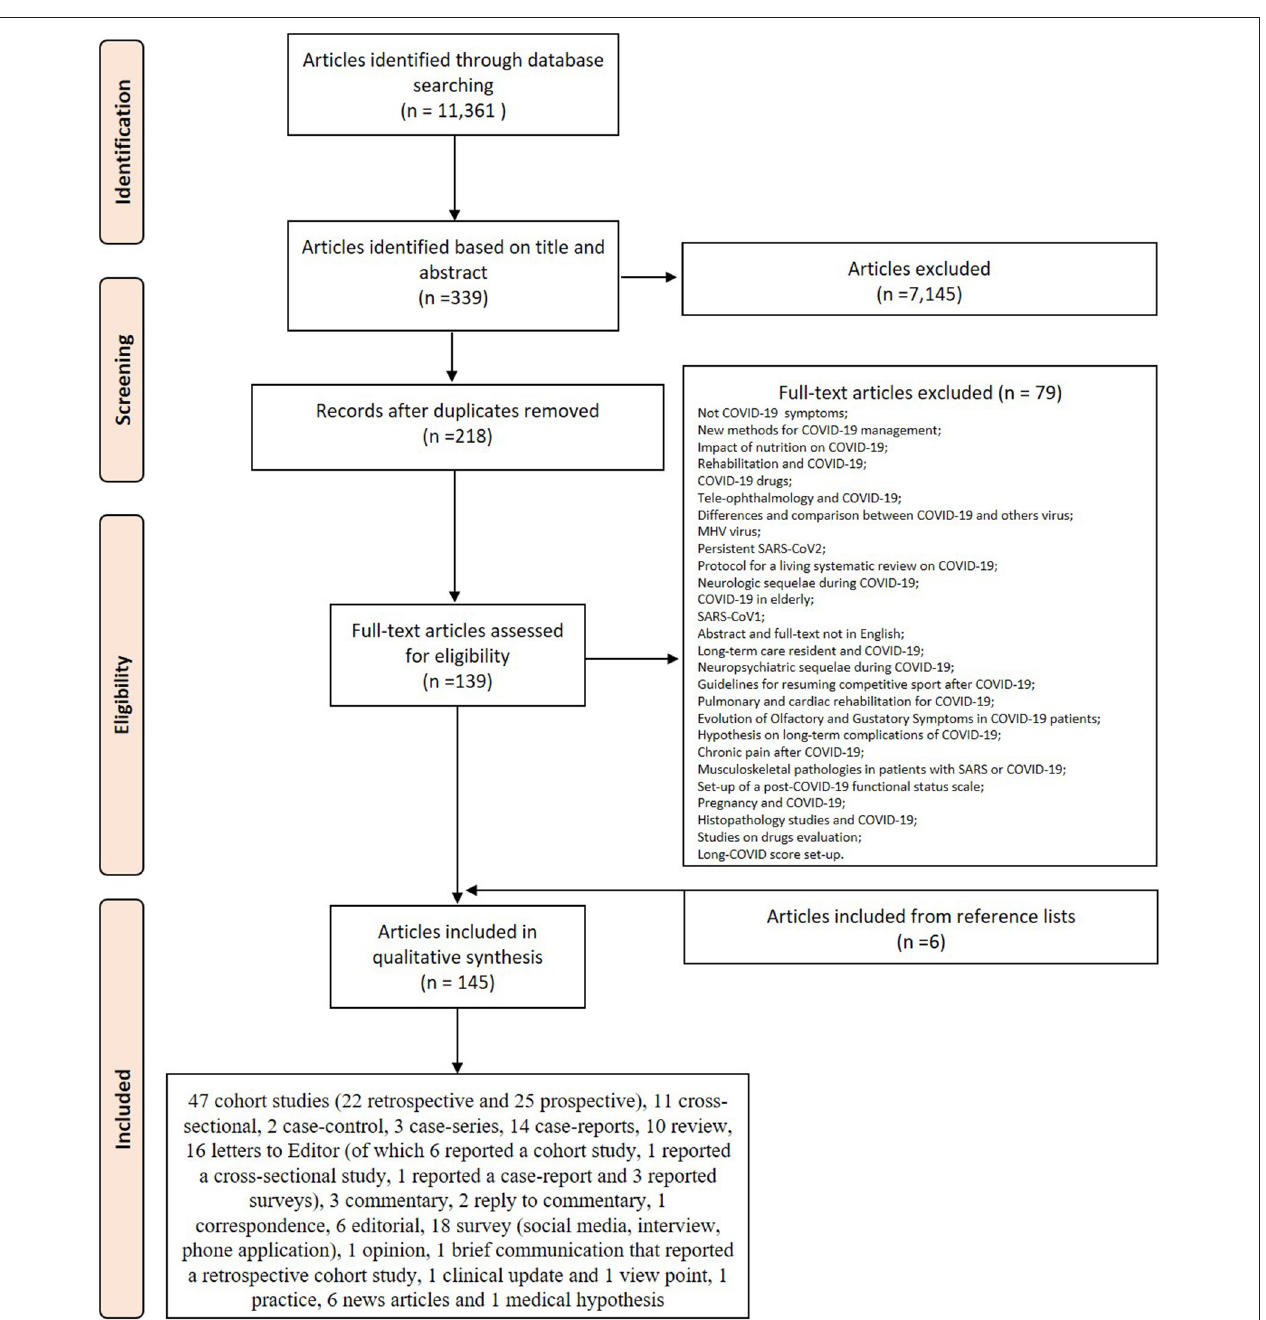
FIGURE 1 | PRISMA flowchart for the study selection.